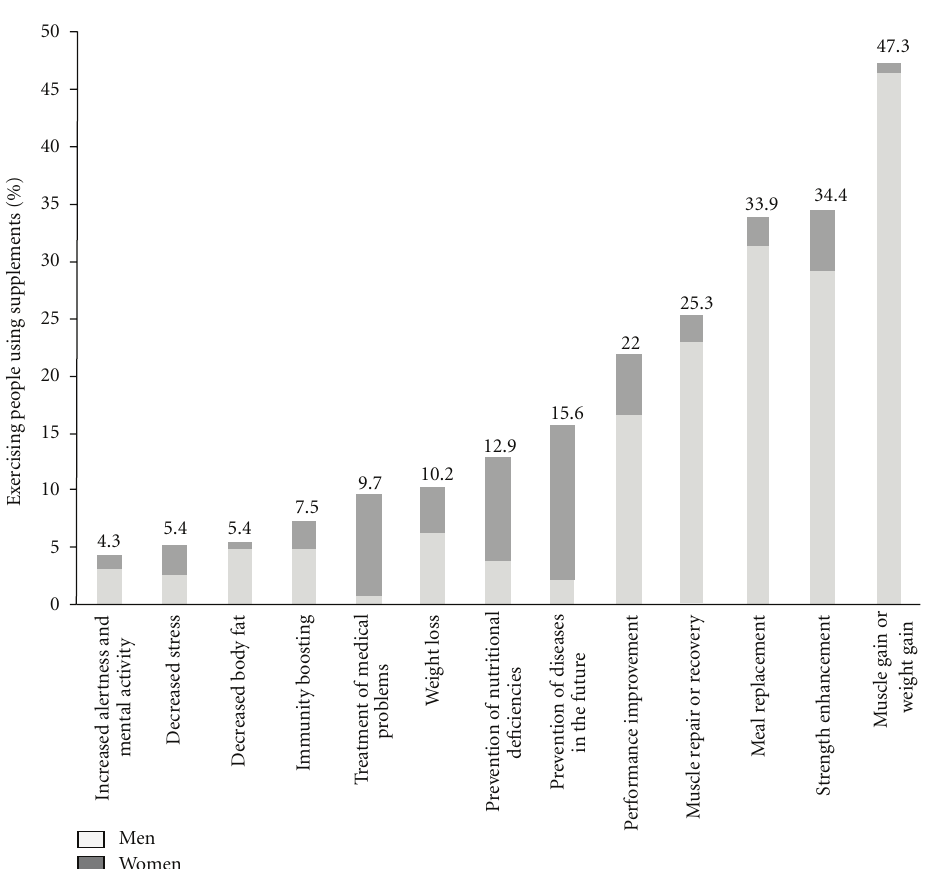
Figure 2: Reasons for supplement use among supplement users ( n = 186). There are no missing data.